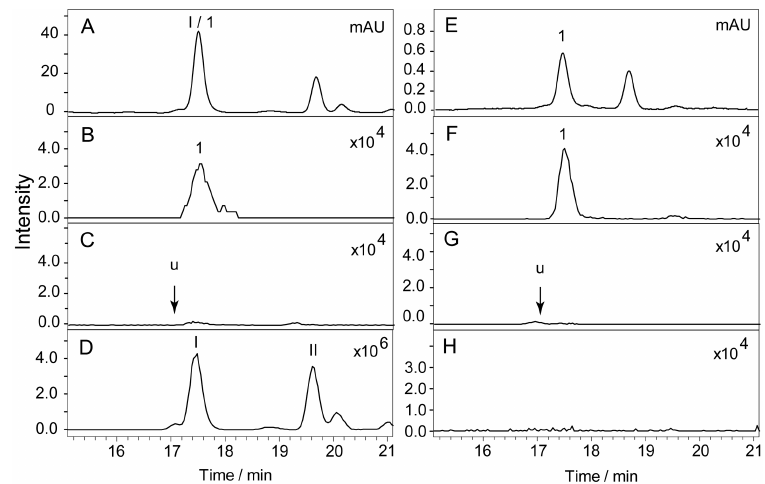
Figure 6. The UV chromatogram (335 nm ( A )) and extracted ion chromatogram (EIC) at m / z 461 ( B ), m / z 463 ( C ) and m / z 547 ( D ) of the ethanol extract of the tap root of S. baicalensis and zinc acetate-pretreated extract ( E – H ); Compounds I and II removed by zinc acetate treatment ( H ); 1 = scutellarin; I = 8-arabinosyl-6-glucosyl-5,7-dihydroxyflavone; II = 6-arabinosyl-8-glucosyl-5,7-dihydroxyflavone; Compounds I and II were identified by their retention times according to the literature [21].